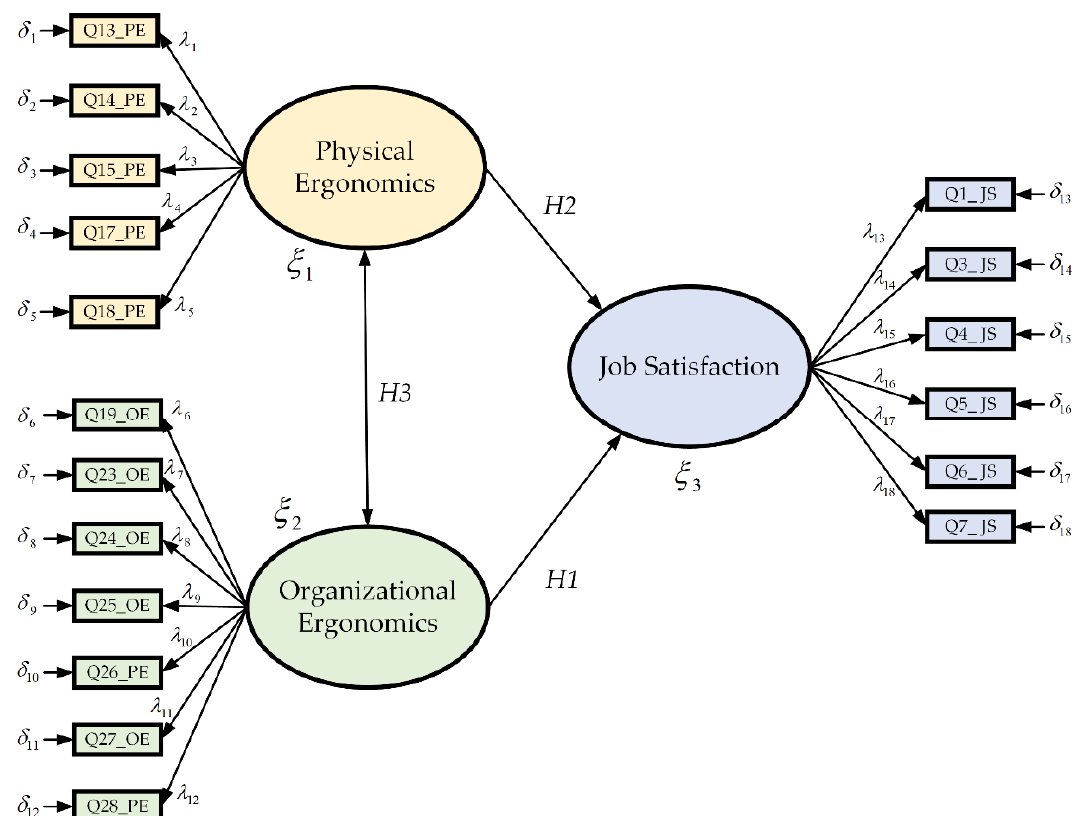
Figure 2. The first test of the model.